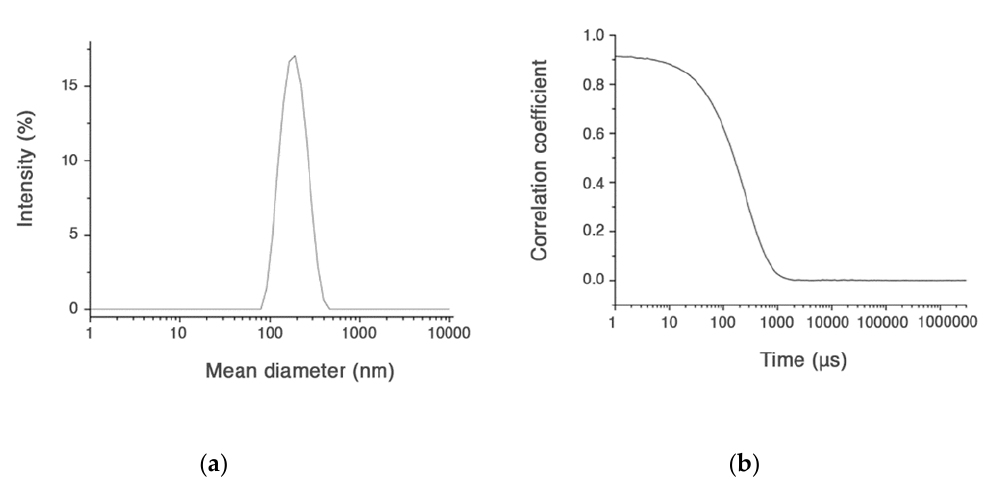
Figure 2. Size distribution ( a ) and intensity correlation functions for CUR-HA-palmitate ( b ).